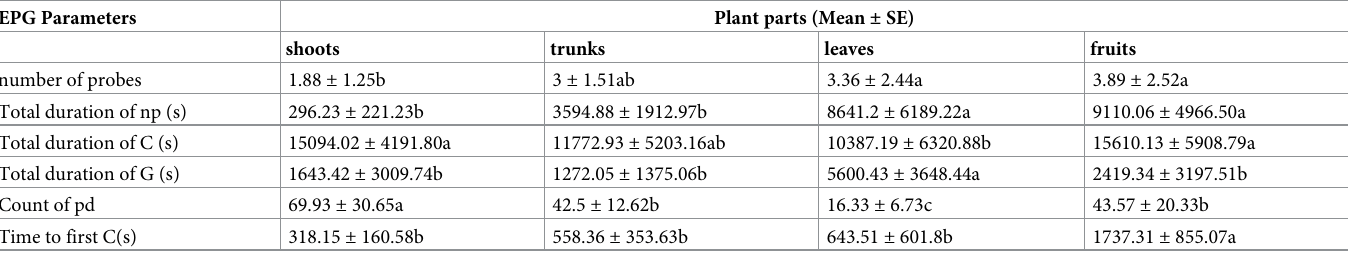
Table 1. Comparison of EPG parameters of woolly apple aphid, Eriosoma lanigerum , during non-phloem feeding on four parts of apple trees (var. Starkrimson). EPG